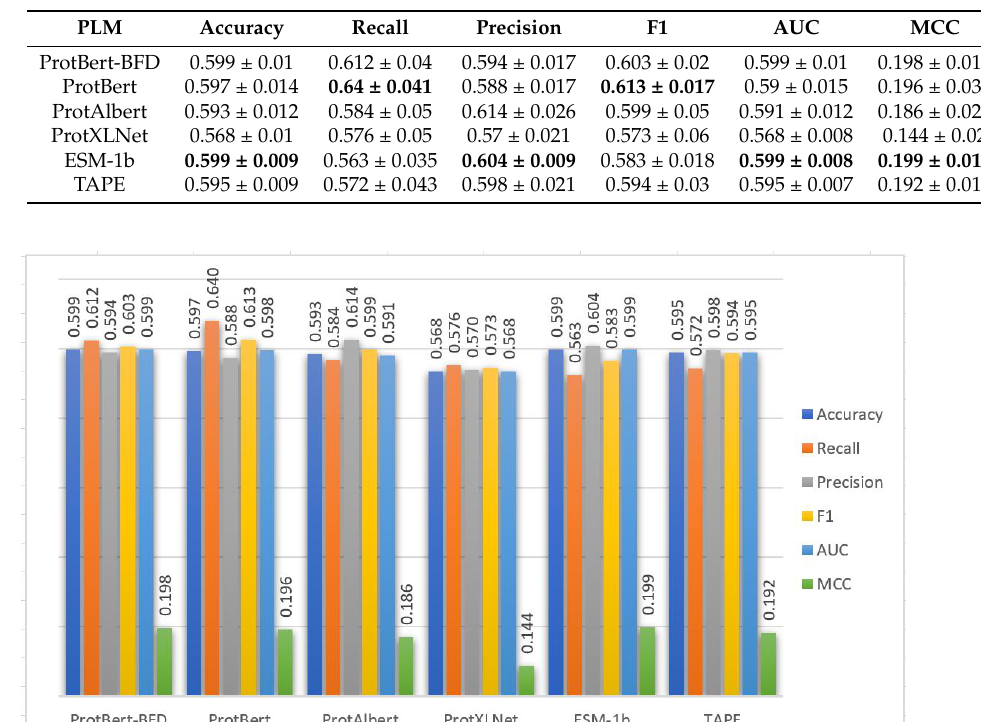
Table 6. Cross-validation performance of CNN model based on the six PLMs on the Kgly dataset. The results of the five-fold cross-validation on the training dataset are represented by the average ± standard deviation for all performance measures.